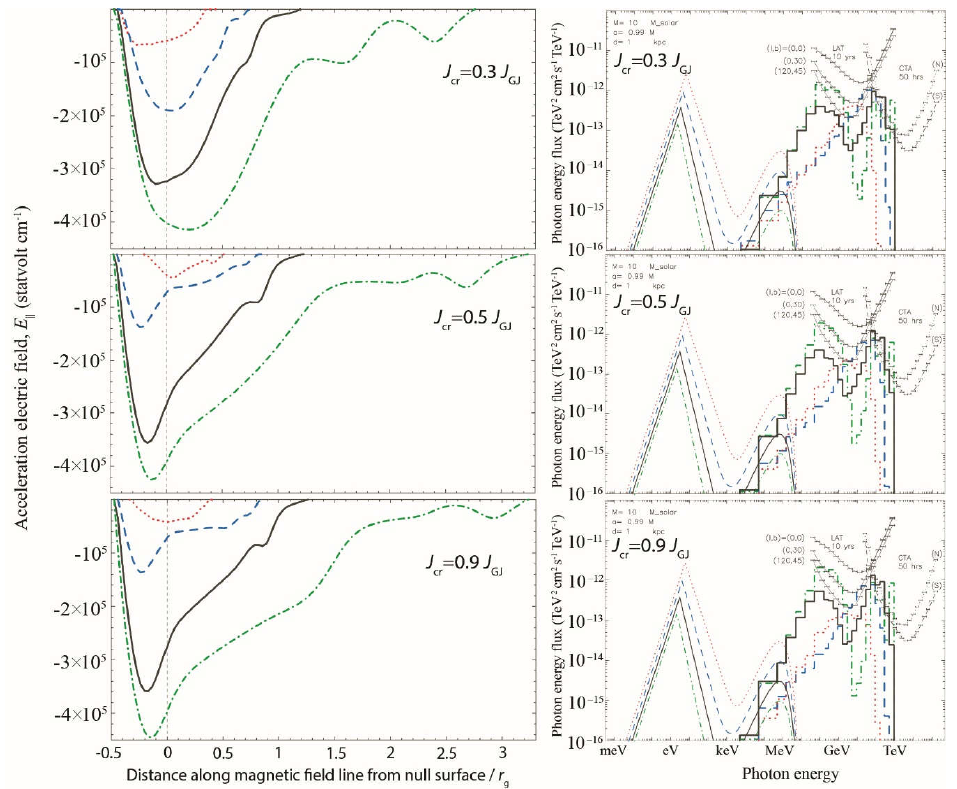
Figure 14. Dependence of the magnetic field-aligned electric fields E (cid:107) ( s ) (left panels) and the SEDs (right panels) on the created current within the gap. From the top, the created current density is 30%, 50%, and 90% of the GJ value. In all the three cases, the injected current density across the inner or outer boundaries is set to be zero. The curves corresponds to the accretion rate of dotted), 1.77 × 10 − 4 (blue dashed), 1.00 × 10 − 4 (black solid), and 5.62 × 10 − 5 (green dash-dotted). From